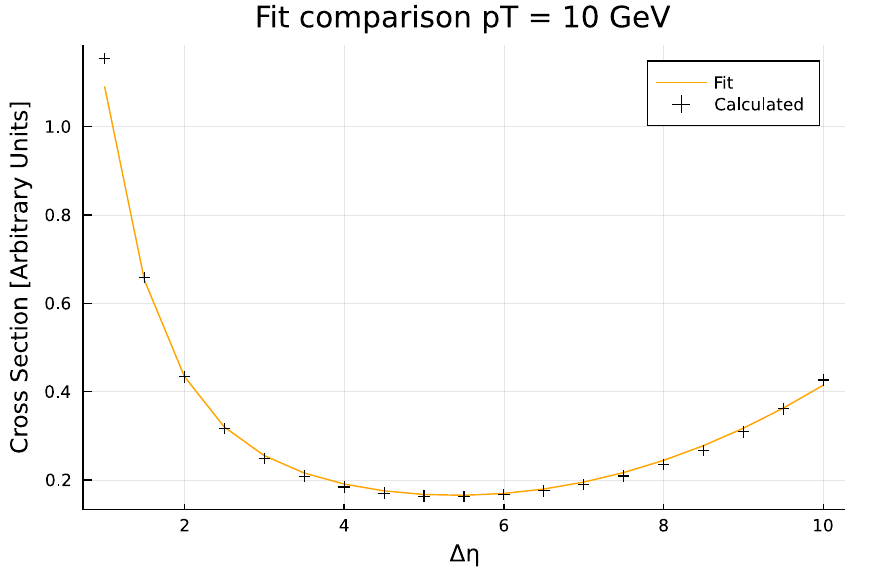
Figure 15 . NLL BFKL cross section as a function of ∆ η jets calculated with eq. (2.4) (crosses) and our fit (orange line) with the parametrization in eq.